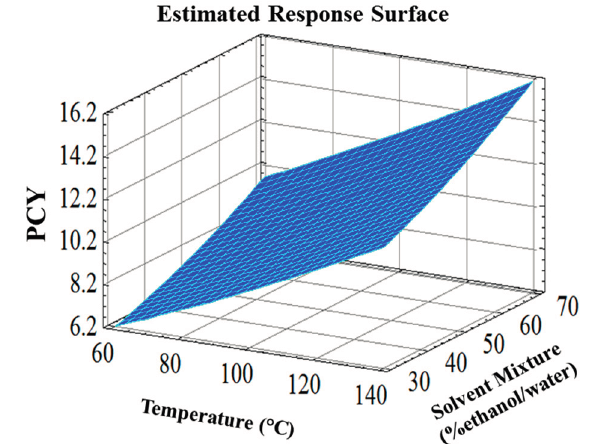
Figure 2. Response surface plot for PCY as function of temperature and solvent mixture,